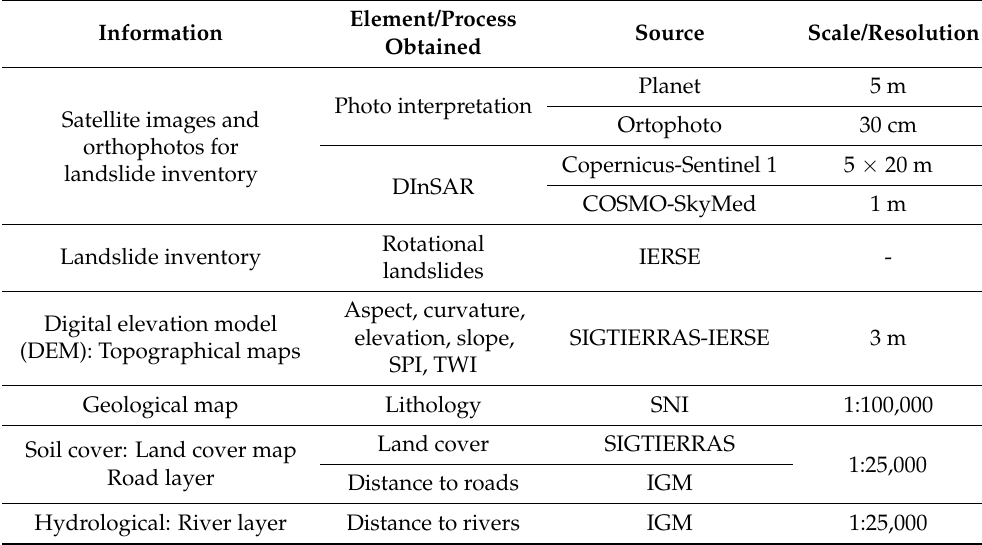
Table 1. Information utilized in this